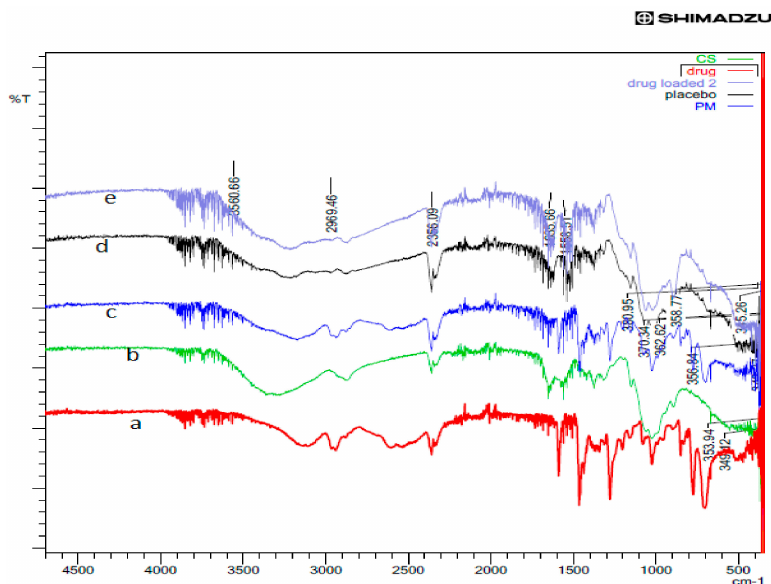
Figure 10. FTIR spectra of ( a ) rotigotine, ( b ) chitosan, ( c ) physical mixture, ( d ) placebo CS NPs, and ( e ) rotigotine-loaded CS